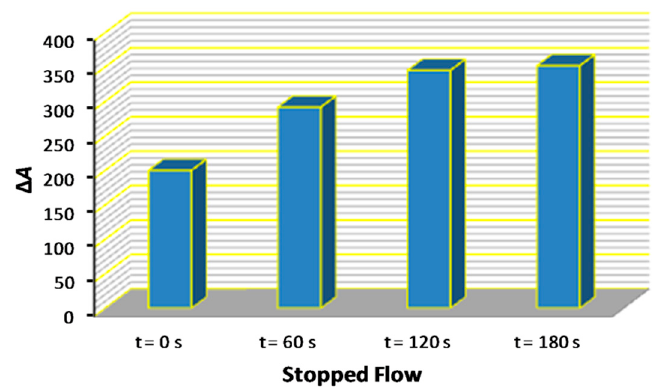
Figure 1. E ff ect of the reaction time on the sensitivity of the method under stopped-flow Figure 1. Effect of the reaction time on the sensitivity of the method under stopped-flow conditions.